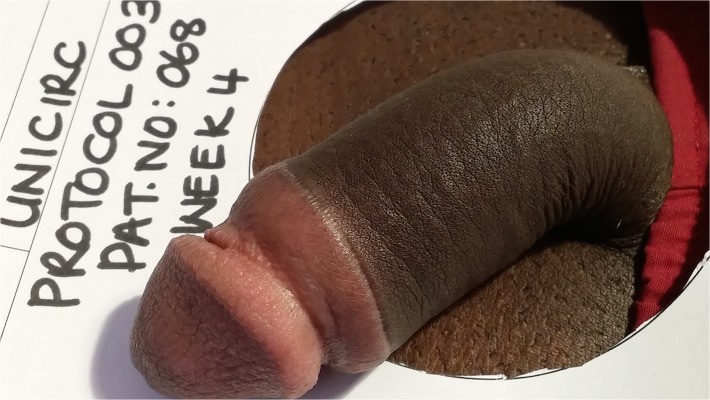
Four-week follow-up.